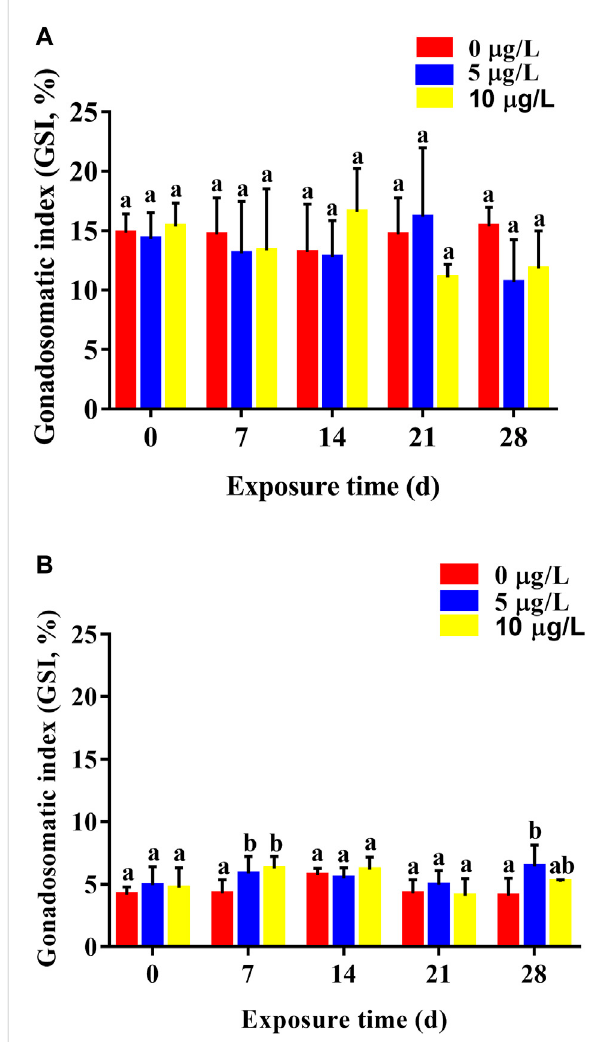
FIGURE 3 Condition factor (mean ± SD) of rare minnows ( Gobiocypris rarus ) exposed to 0, 5, and 10 μ g/L Cd for 28 days ( n = 3). (A) Female rare minnows; (B) Male rare minnows. Bar with different letters between the control and exposed groups for the same day indicates statistically signi fi cant differences ( p < 0.05).